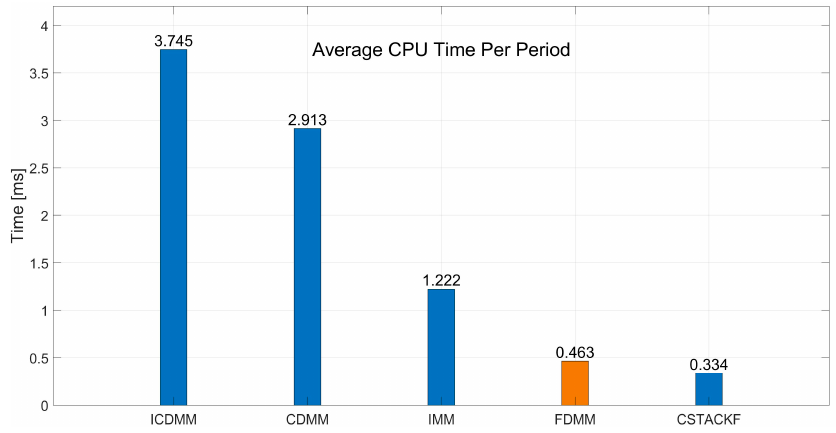
Figure 8. The average CPU time per period for different algorithms in Case 1.